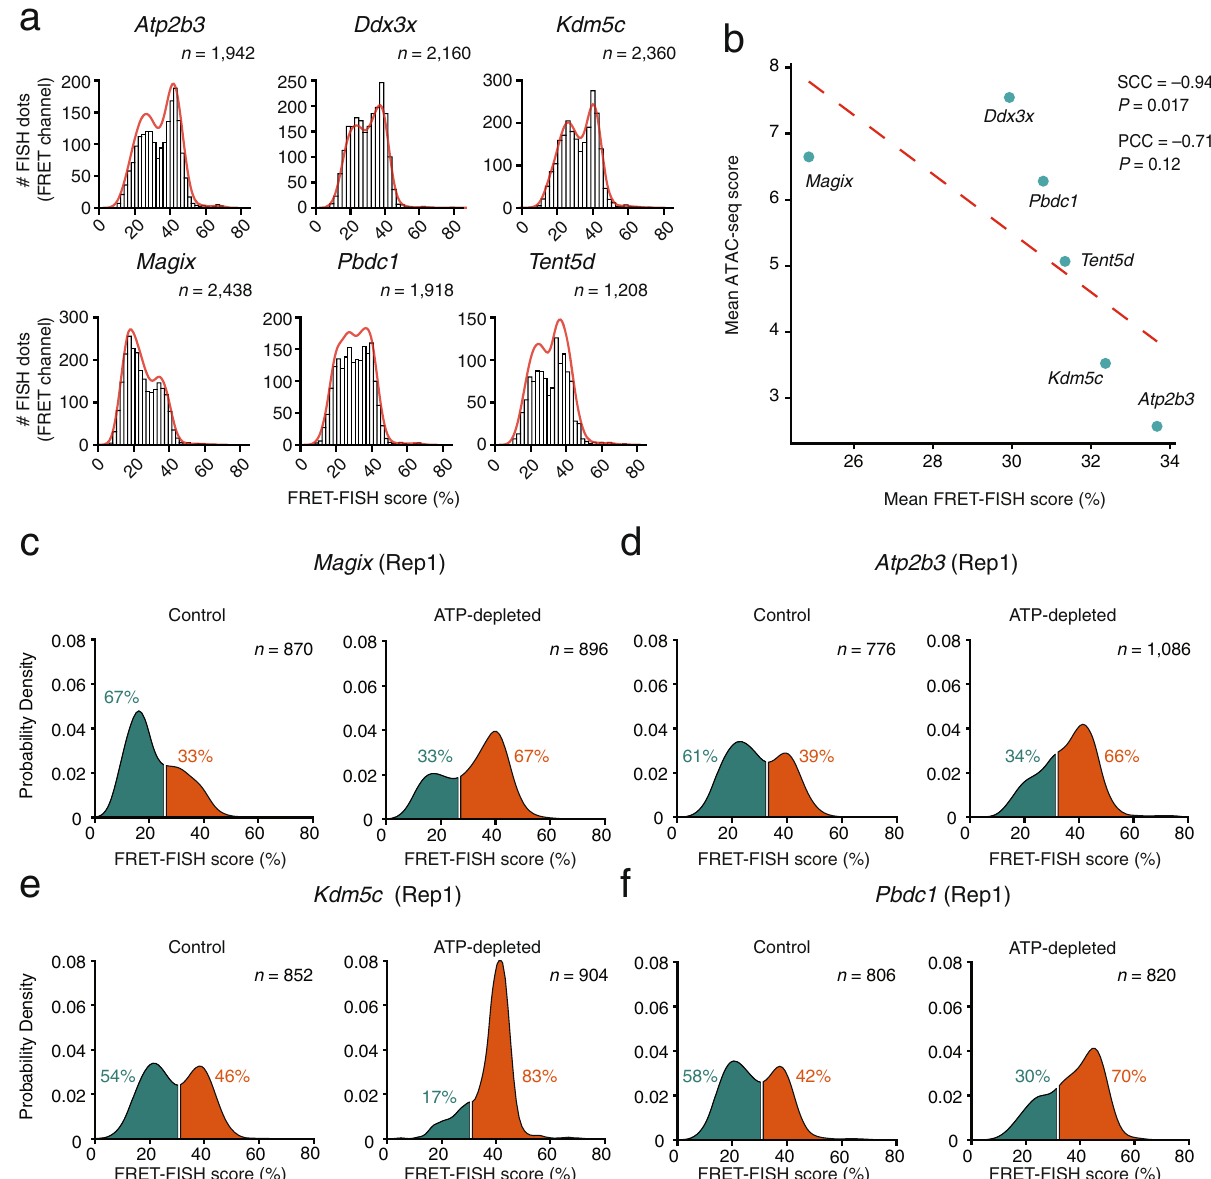
Fig. 2 | FRET-FISH validation. a FRET-FISHscoredistributionsforsix loci targeted on chrX in female mouse embryonic fi broblasts (MEFs). Measurements from three replicate experiments pooled together are shown. Red lines, kernel density esti- mation function. n , number of FRET signals analyzed from three independent experiments. b Correlationbetween the meanFRET-FISHscoreof the sixgene loci shownin ( a )and the mean ATAC-seqscoreofthe corresponding genomic regions. SCC Spearman ’ s correlation coef fi cient, PCC Pearson ’ s correlation coef fi cient, P Wilcoxontest,two-tailed.Dashedredline,linearregression fi t. c – f FRET-FISHscore